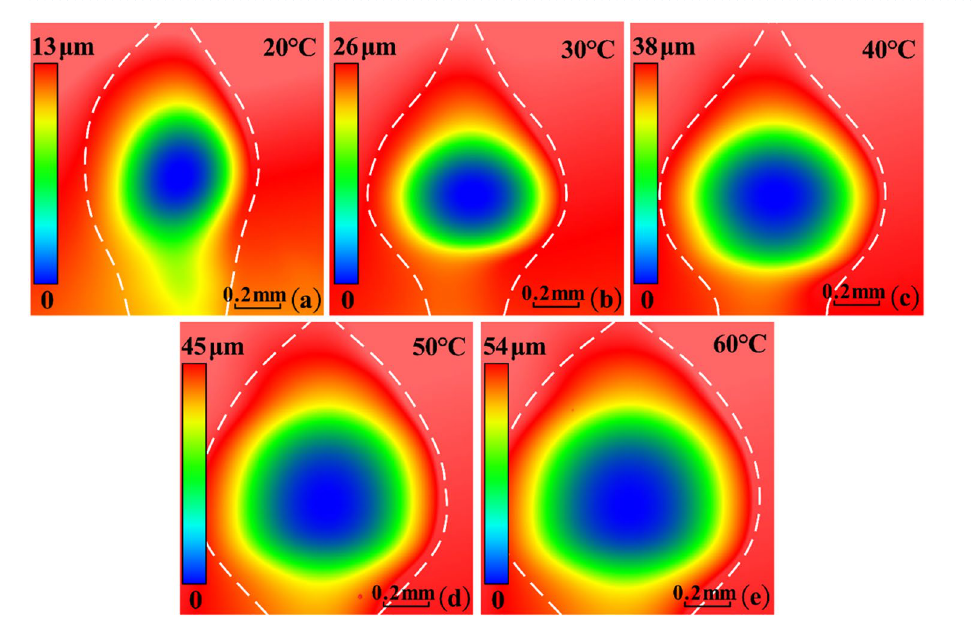
Figure 10. The shape of teardrop-shaped polished pits. ( a ) 20 °C; ( b ) 30 °C; ( c ) 40 °C; ( d ) 50 °C; ( e ) 60